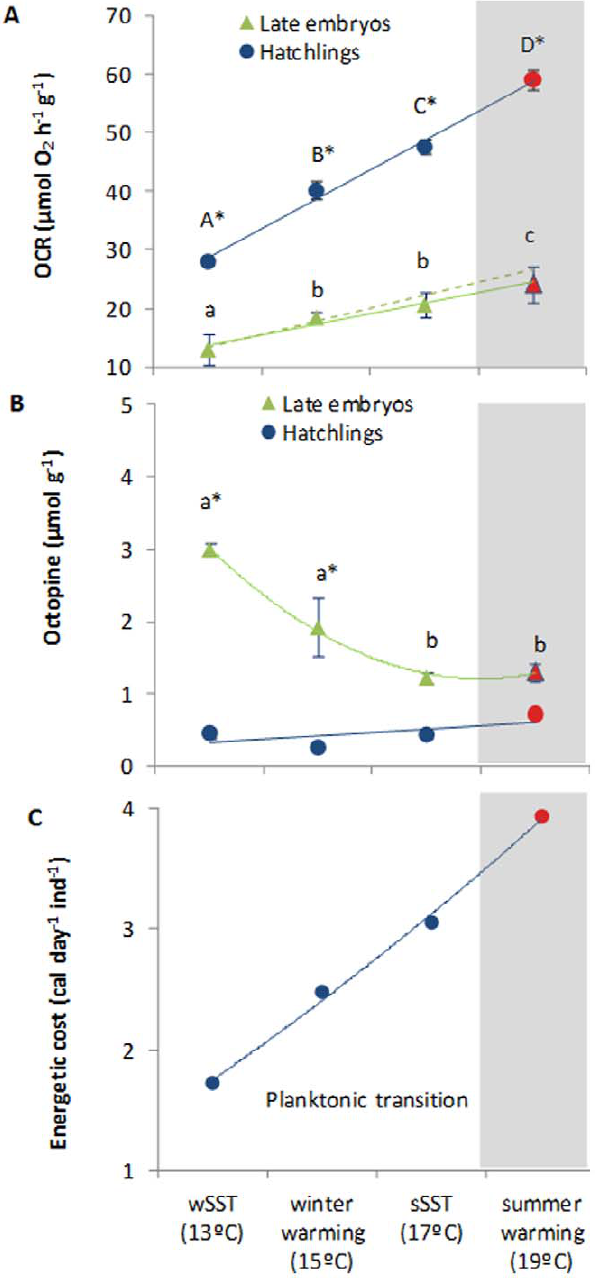
Figure 4. Metabolic physiology of squid ( Loligovulgaris ) late embryos and hatchlings: A) oxygen consumption rates ( m mo- lO 2 h 2 1 g 2 1 ), B) octopine concentration ( m mol g 2 1 ), and C) individual energetic cost of the planktonic transition (cal day 2 1 ind 2 1 ), at the different temperature scenarios (red symbols highlight the future summer scenario). Values are mean 6 SD. Colored lines represent trendlines and different letters (capital letters for hatchlings; small letters for embryos) and asterisks represent significant differences between temperatures and developmental stages, respectively (more statistical details in Supporting Tables). In panel A, the ‘‘expected’’ trend is represented by the dash line assuming a Q 10 of 2.5. In panel C, the energy-related values do not have any associated variance because they represent the metabolic augment (in calories, based on 4.7 kcal L 2 1 O2) from late embryos to planktonic paralarvae (i.e. using mean values from panel A).